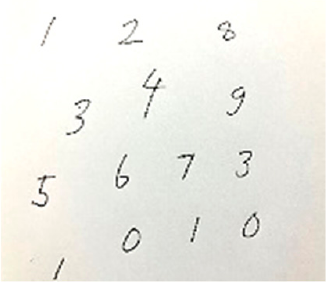
Figure 1. Example of a handwritten document.